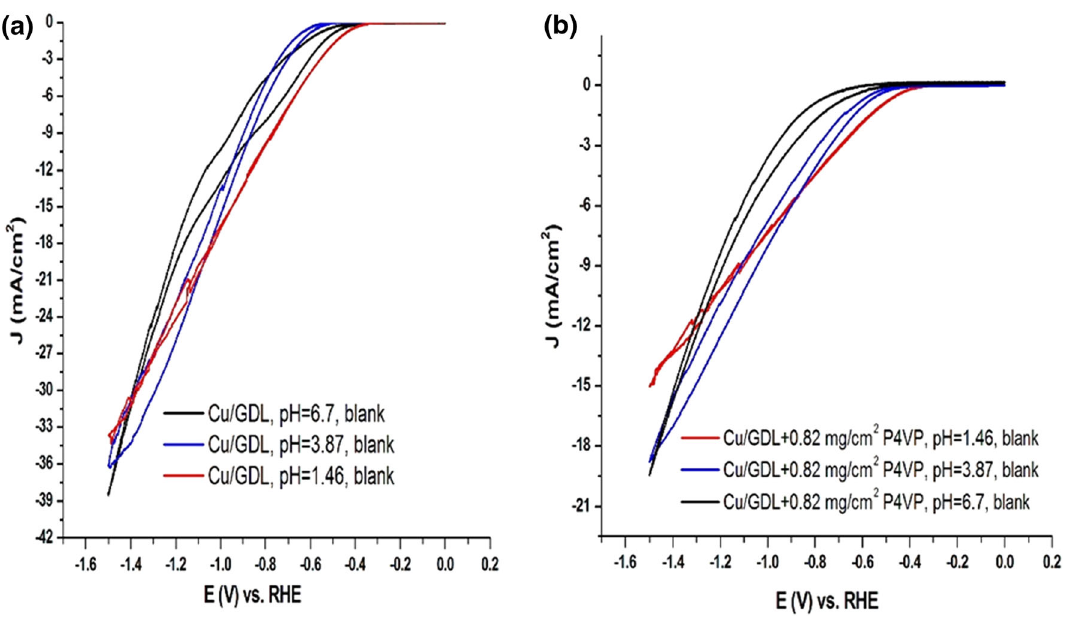
Fig. 1 CV curve of Cu/GDL with different P4VP loadings in phosphate buffer electrolyte at pH 1.46, 3.87, and 6.7. a Cu/GDL, blank electrolyte, and b Cu/GDL ? 0.82 mg/cm 2 P4VP, blank electrolyte. Scan rate: 50